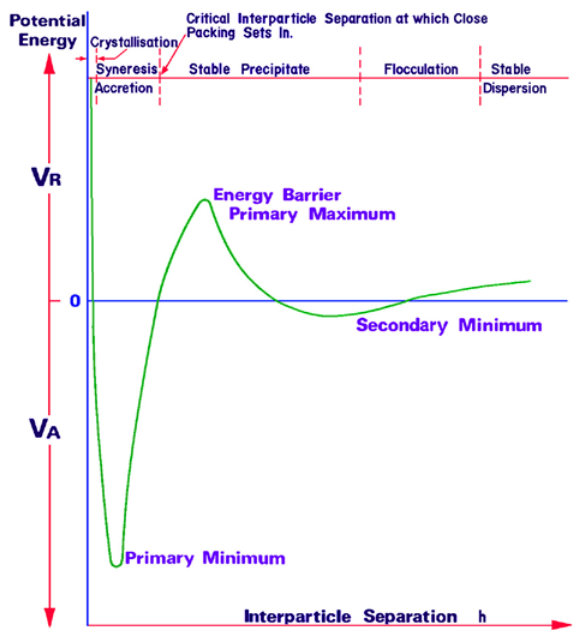
Figure 7. This is a schematic representation of the electrical double layer on colloidal sol particles and the variation of net surface char- ge with pH. [From Healy 6 , 1972, p. 38]